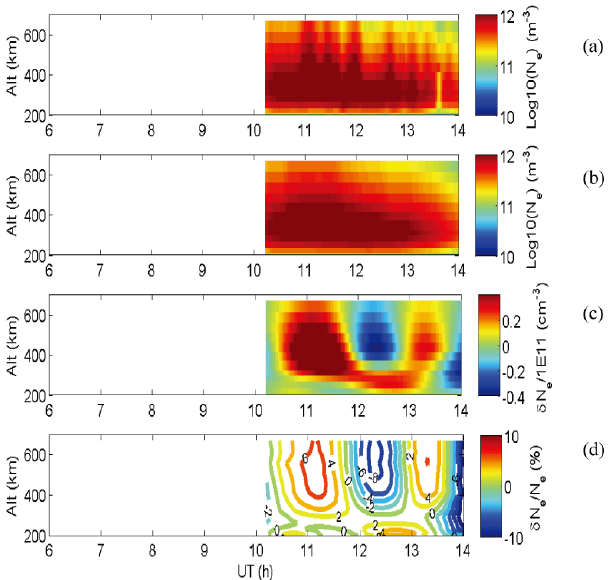
Fig. 4. The same as Fig. 2, but for the EISCAT UHF radar at Tromsø during the interval of 06:00–14:00UT. The white space in the inter- val from 06:00 to 10:00UT is due to a data gap.